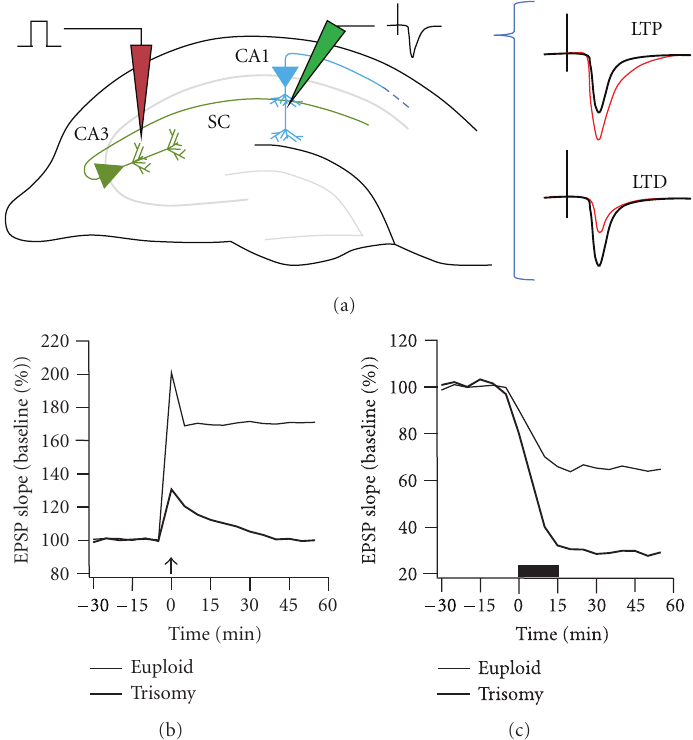
Figure 1: Depiction of altered CA1 hippocampal plasticity in Ts65Dn mice. (a) Diagram indicating electrode placement for stimulating Scha ff er collaterals arising from CA3 and recording the evoked field excitatory postsynaptic potential (EPSP) in CA1. Traces to the right indicate the typical change in evoked responses (red) following LTP and LTD. (b) Simulated data depicting suppressed LTP in Ts65Dn mice. After high-frequency stimulation of SC (at arrow head), the field EPSP increases and remains enhanced in euploid mice but fails to remain elevated in Ts65Dn mice. (c) Simulated LTD data depicting exaggerated depression of evoked EPSPs following low-frequency stimulation of SC in Ts65Dn mice. (Traces in B and C based on data from [44, 45].) of overexpression of these genes on Ts65Dn phenotypes remains to be